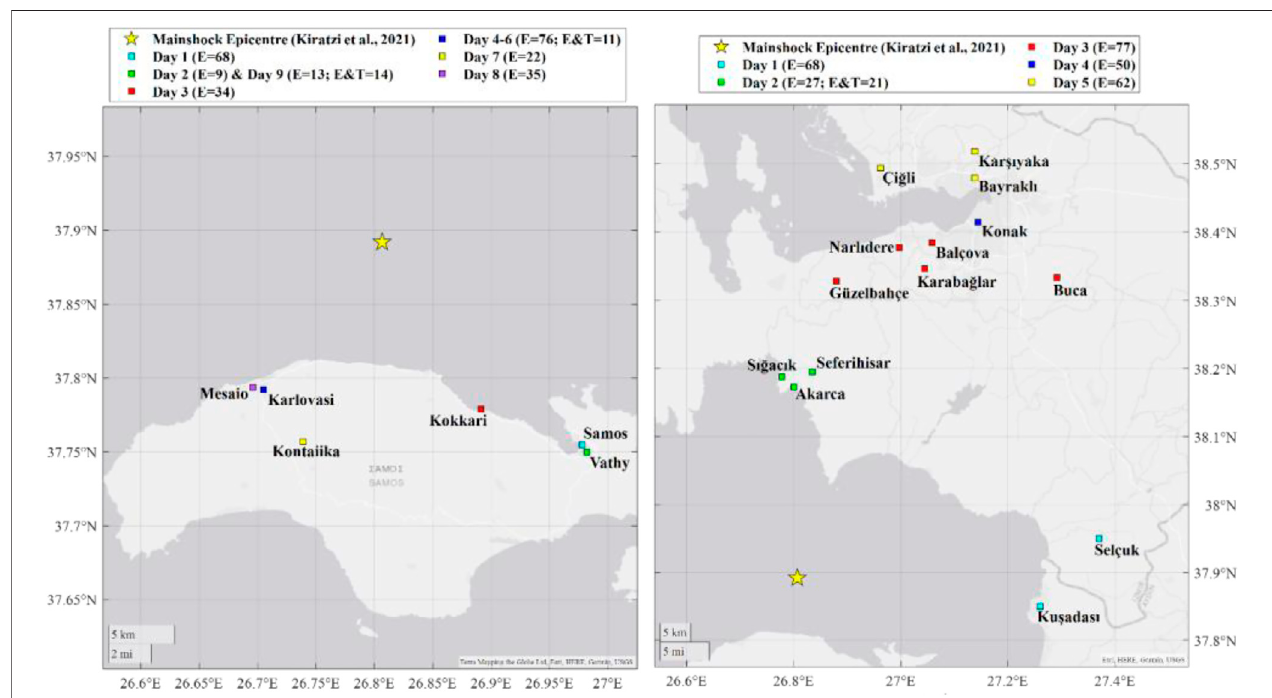
FIGURE 3 | Breakdown of the damage assessment activities in Turkey and